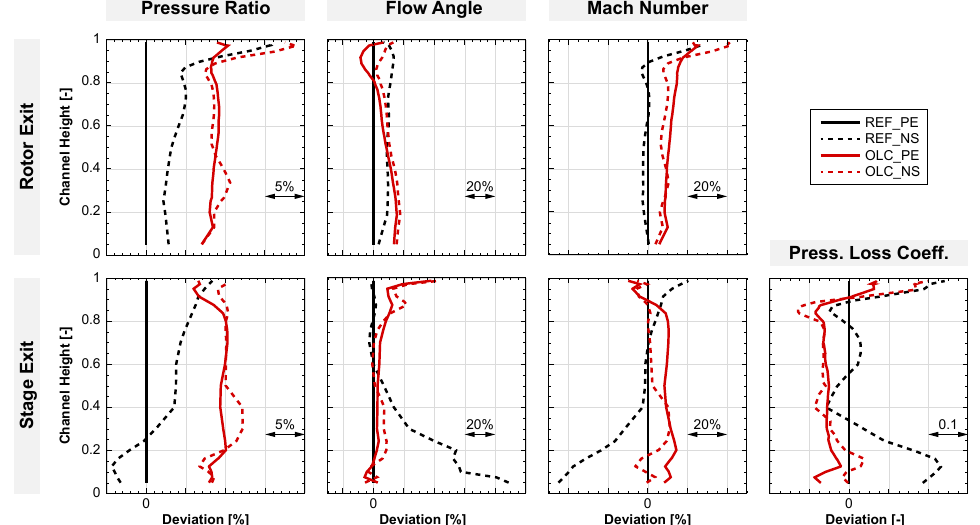
Figure 5. Radial distribution of pressure ratio, flow angle, Mach number and pressure loss coefficient at rotor and stage exit for